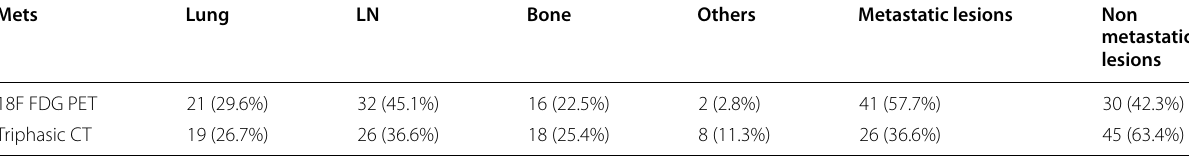
Table 4 Comparison of CT and 18F FDG PET/CT (according to number of metastases) Mets